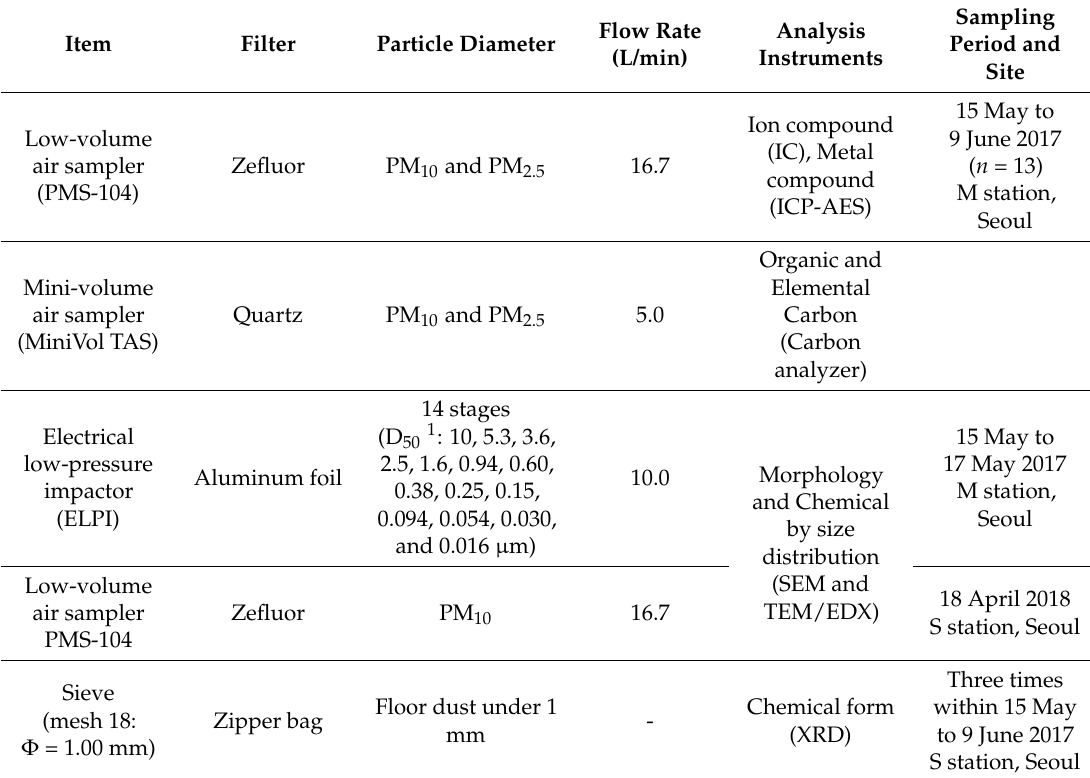
Table 1. Measurement devices and sampling